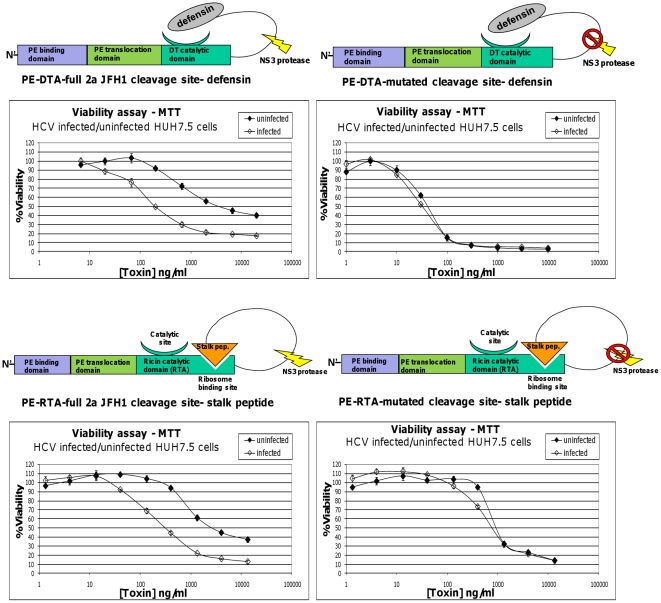
Viability assay of HCV infected/uninfected Huh7.5 cells treated with zymoxins.Huh7.5 cells uninfected or infected with HJ3-5 chimeric virus were seeded (1×104 cells per well) in 96-well plates. After 24 hours, cells were incubated for 96 hours with serial dilutions of the cleavable toxins “PE-DTA-full 2a JFH1 cleavage site-defensin” and “PE-RTA-full 2a JFH1 cleavage site- stalk peptide”, or their uncleavable controls. The relative fraction of viable cells was determined using an enzymatic MTT assay. A representative graph of three independent experiments is shown. Each point represents the mean ±SD of a set of data determined in triplicates.